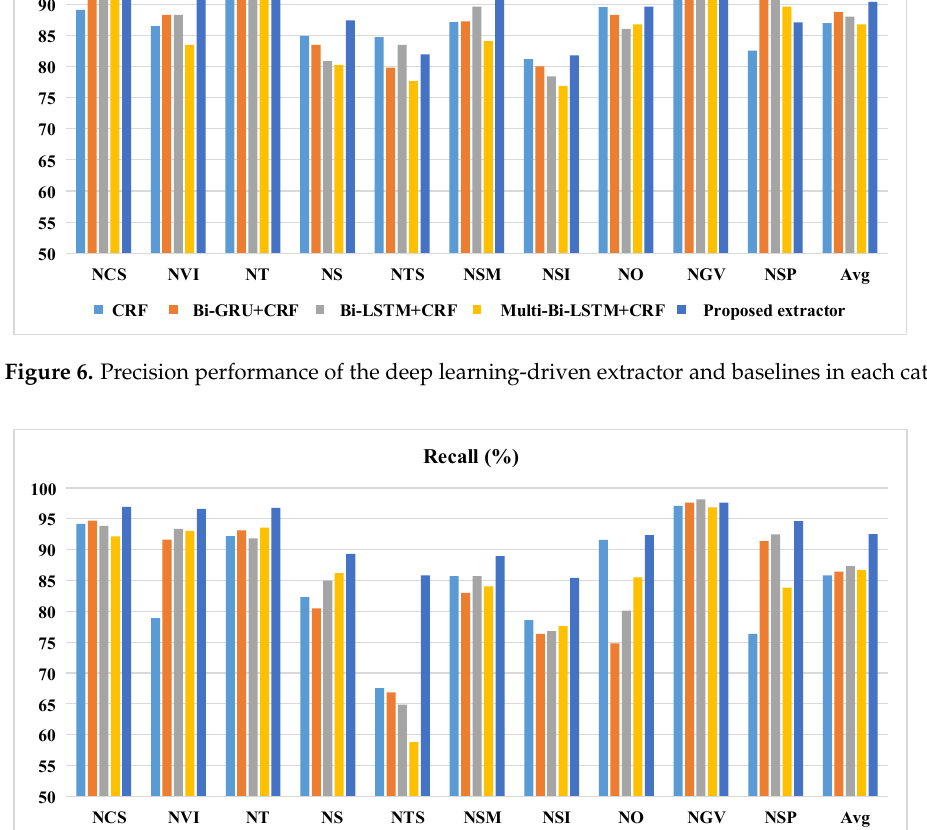
Figure 7. Recall performance of the deep learning-driven extractor and baselines in each category.